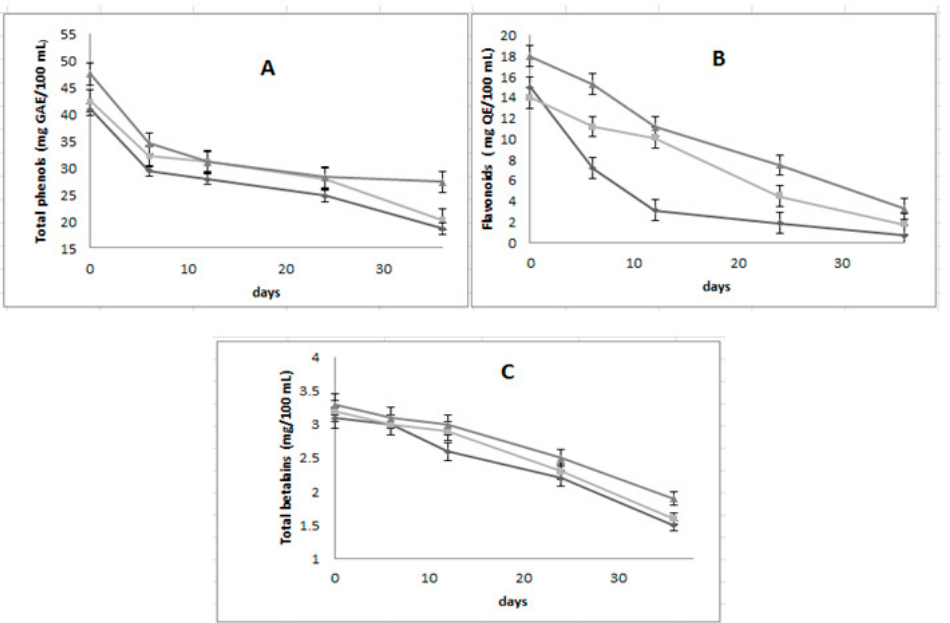
Figure 2. Content of total phenol ( A ), total flavonoids ( B ) and betalains; ( C ) of three multiple emulsions formulated with two polymers, arabic gum (GA) and maltodextrin (MD): AG40%-MD60% AG50%-MD50% and AG60%-MD40% during 36 days of storage.